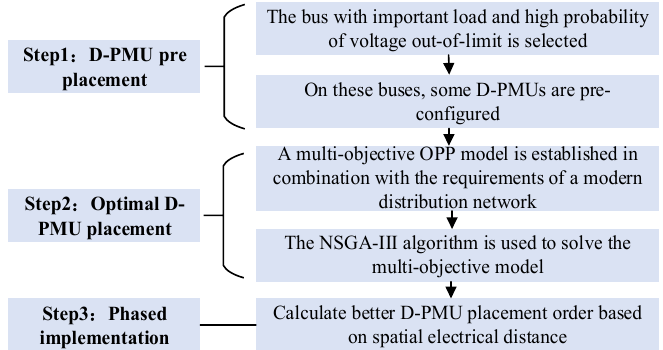
Figure 2. The main process of D-PMU placement.